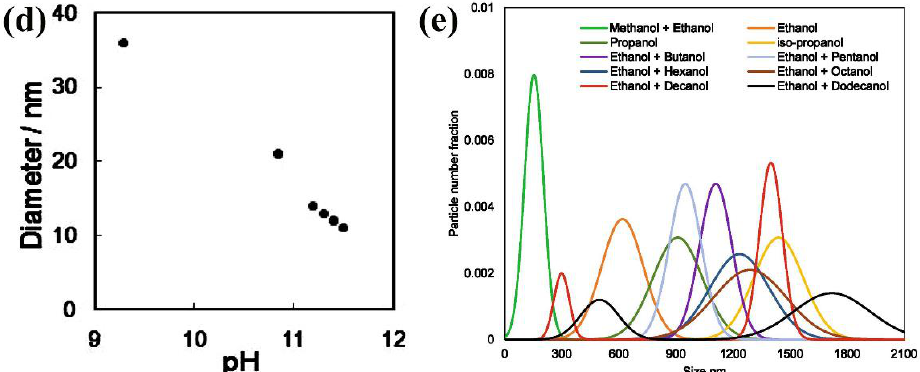
Figure 1. Illustration of sol-gel synthesis of SNs. ( a ) Schematic illustration of the formation process of SNs. Adapted with the permission from [107]. Copyright 2016, Royal Society of Chemistry. ( b ) SEM image of the synthesized SNs at 20 °C for 20 min. Adapted with the permission from [107]. Copyright 2016, Royal Society of Chemistry. ( c ) SEM Image of the synthesized SNs under the condition of pH = 10.8. Adapted from [104]. Copyright 2011, American Chemical Society. ( d ) Relationship between the initial pH of the water phase and the average diameter of SNs. Adapted with the permission from [104]. Copyright 2011, American Chemical Society. ( e ) Particle size distribution of SNs synthesized in different solvents with NH 3 = 1 M, H 2 O = 7 M, temperature 55 °C. Adapted with the permission from [35]. Copyright 2020, Elsevier.